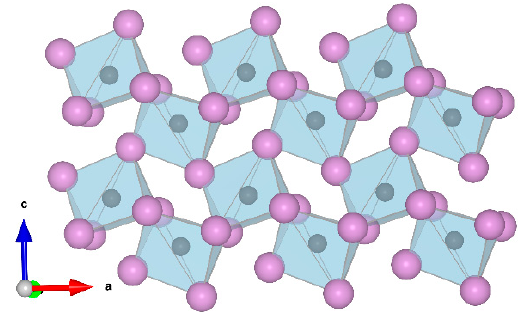
Figure 3. Crystal structure of the cementite type Ni 3 C at 184(5) GPa and room temperature. Purple and black spheres designate nickel and carbon atoms, correspondingly.